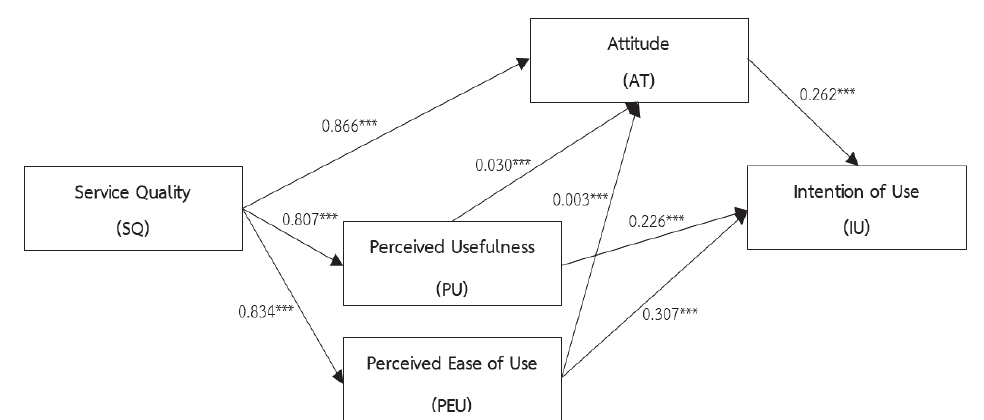
Fig. 4. Final analysis of structural model (Large)